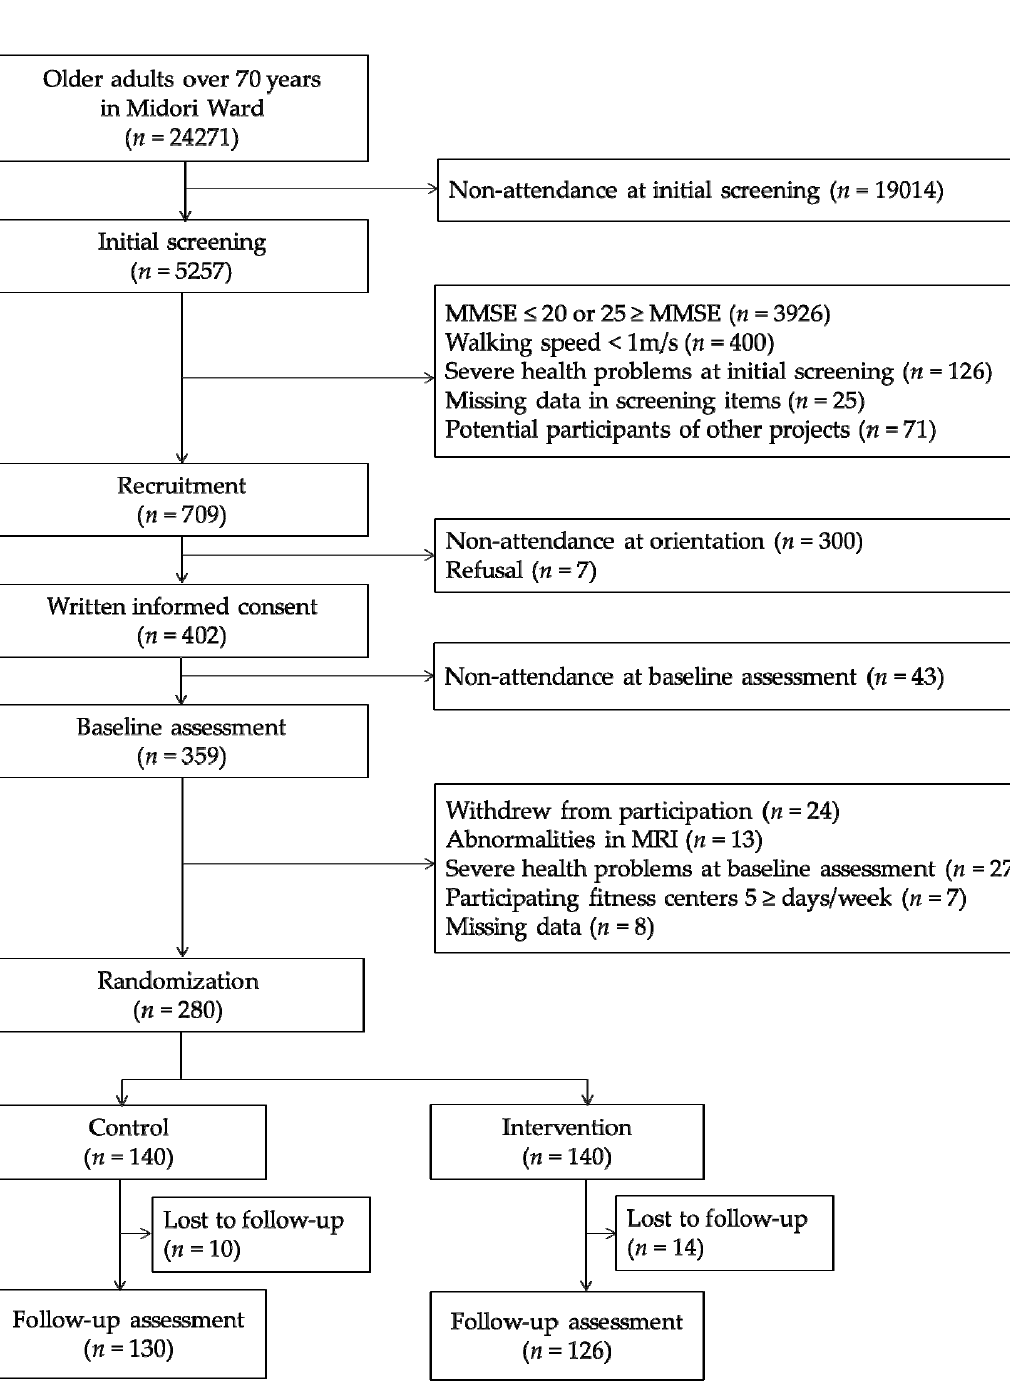
Figure 1. Flowchart of the participants’ recruitment process. MMSE, Mini-Mental State Examination; MRI, Magnetic resonance imaging. MRI, Magnetic resonance